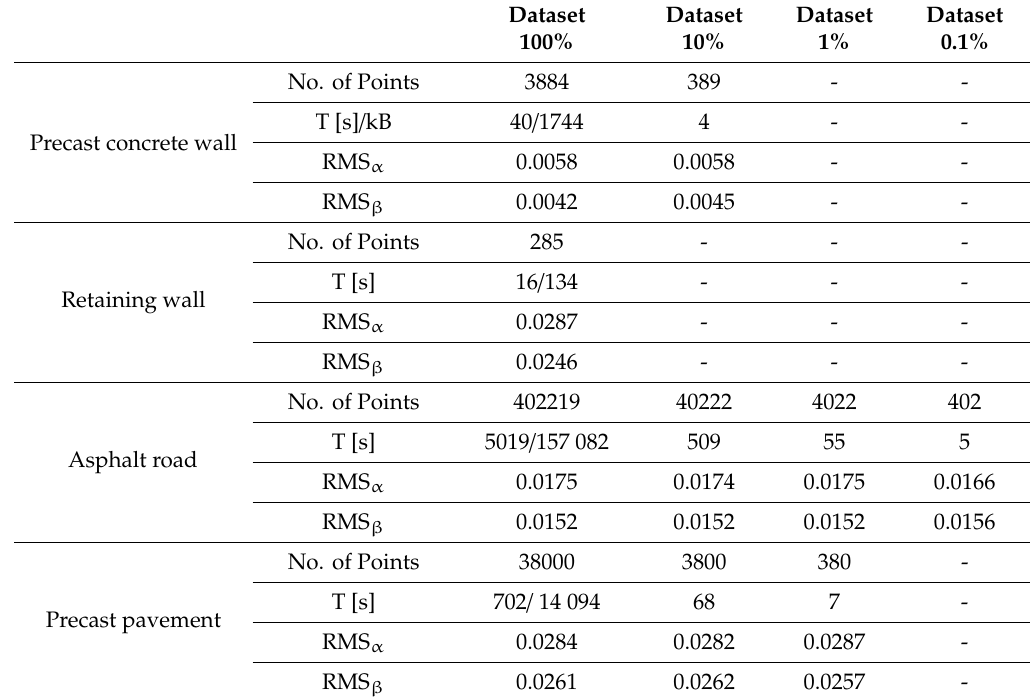
Table 3. An e ffi ciency analysis (the computation time and RMS